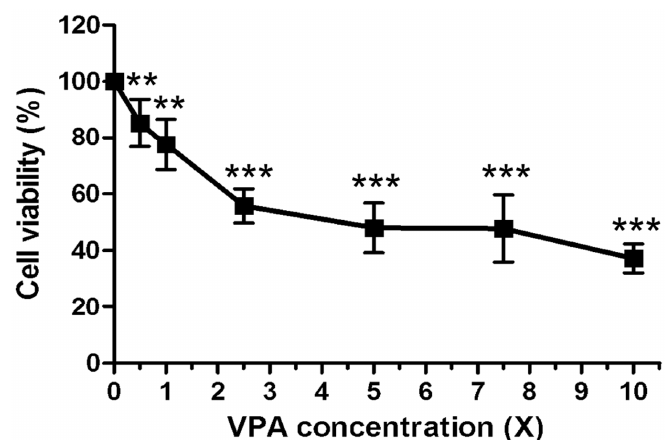
Figure 2. The inhibitory effect of VPA on the growth of rat chondrocytes is dose-dependent. Values are percentages of control. Rat chondrocytes were treated with consecutive 5 days with varying concentrations of VPA (1X= 60 μ g/mL) (IC50 ≒ 5X) ( n = 6, ** p <0.01, *** p < 0.001, compared with control).